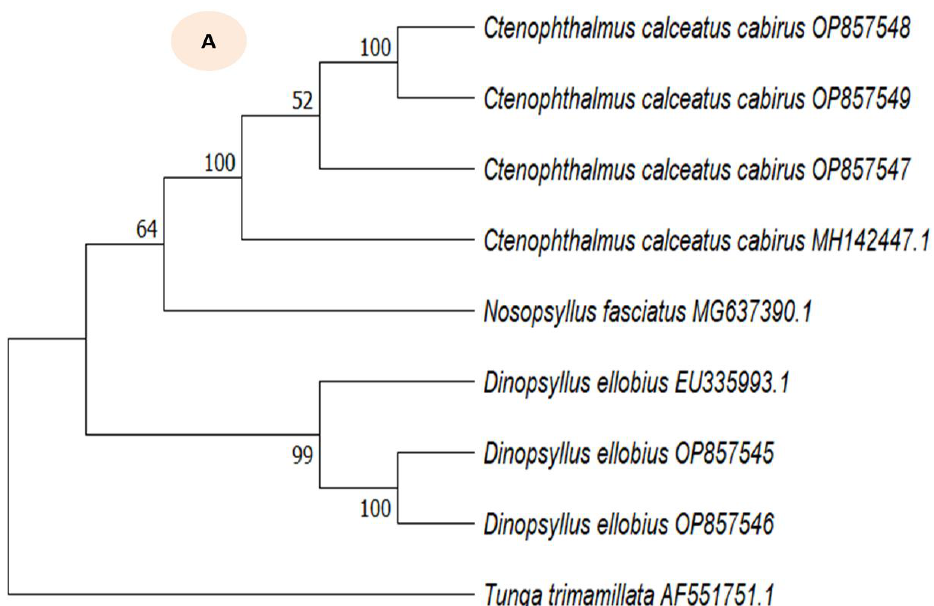
Figure 2. ( a ) Mounted vouchers of flea species: F1— Dinopsyllus ellobius (female, a—spermatheica); F2— Ctenophthalmus calceatus cabirus (front part; e—genal ctenidia with three spines, f—Pronotal ctenidia); F3— Xenopsylla cheopis (male; h—clasper); F4— Dinopsyllus ellobius (male, b—clasper); F5— Dinopsyllus ellobius (front part; c—Pronotal ctenidia, d—genal ctenidia); F6— Xenopsylla cheopis (male; h—clasper). ( b ) Ventral view of Laelaps mite (L) and Varroa mite (V) [69]. Varroa (V): Sternal plate (sp) fused with genital shield (gs); genital shield is large with lateral deep and angular projections; metapodal shields (mps) greatly enlarged and broadly triangular. Laelaps (L): Genital shield is flask-shaped and distinctive from the sternal plate. Both mites possess one post anal setae in the anal plate (ap).